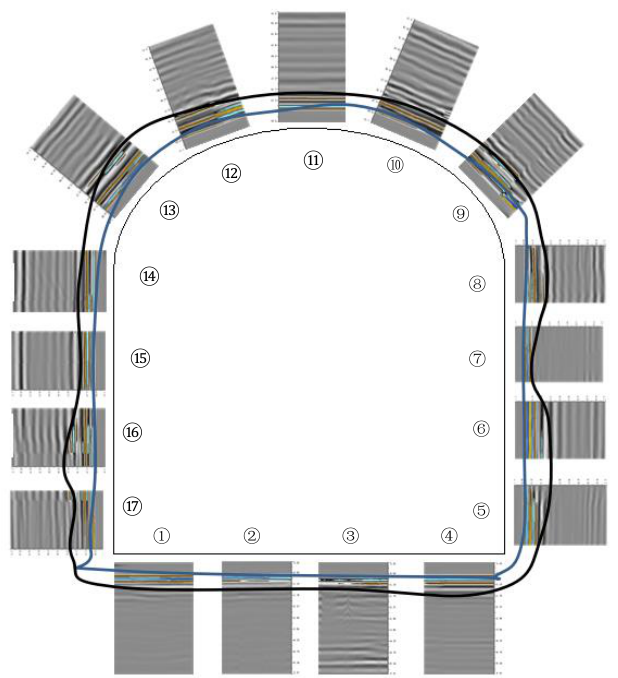
Figure 14. Scanning graph of surrounding rock loose circle in the 360,803 airway.